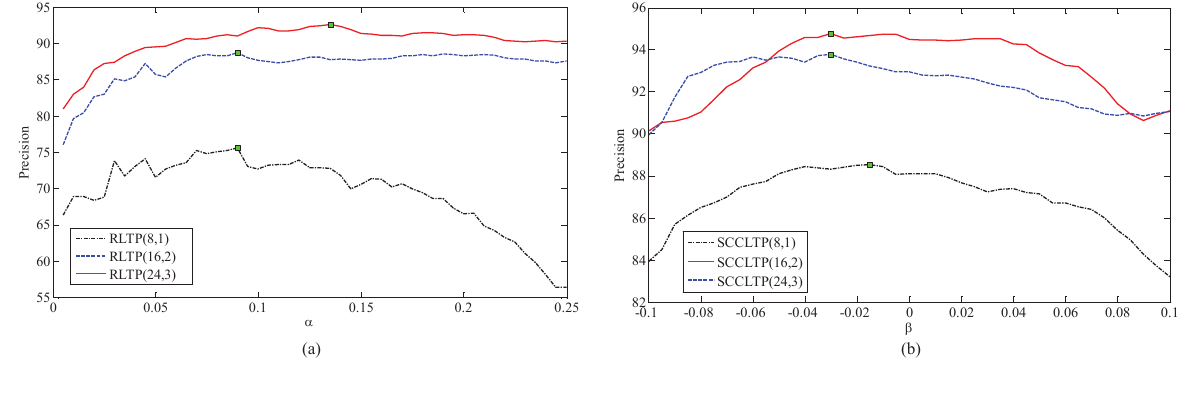
Figure 6. The curve of precision vs . α and β on TC12_001. ( a ) The results of RLTP(8,1), RLTP(16,2) and RLTP(24,3). ( b ) The results of SCCLTP(8,1), SCCLTP(16,2) and SCCLTP(24,3). Table 2. Classification accuracy (%) on the TC10 and TC12 texture sets.